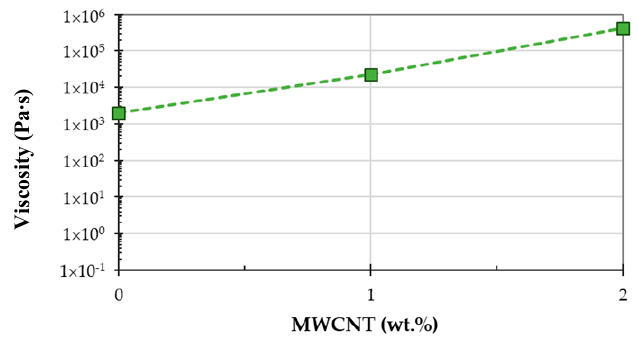
Figure 6. Resin system viscosity containing different amounts of MWCNT.